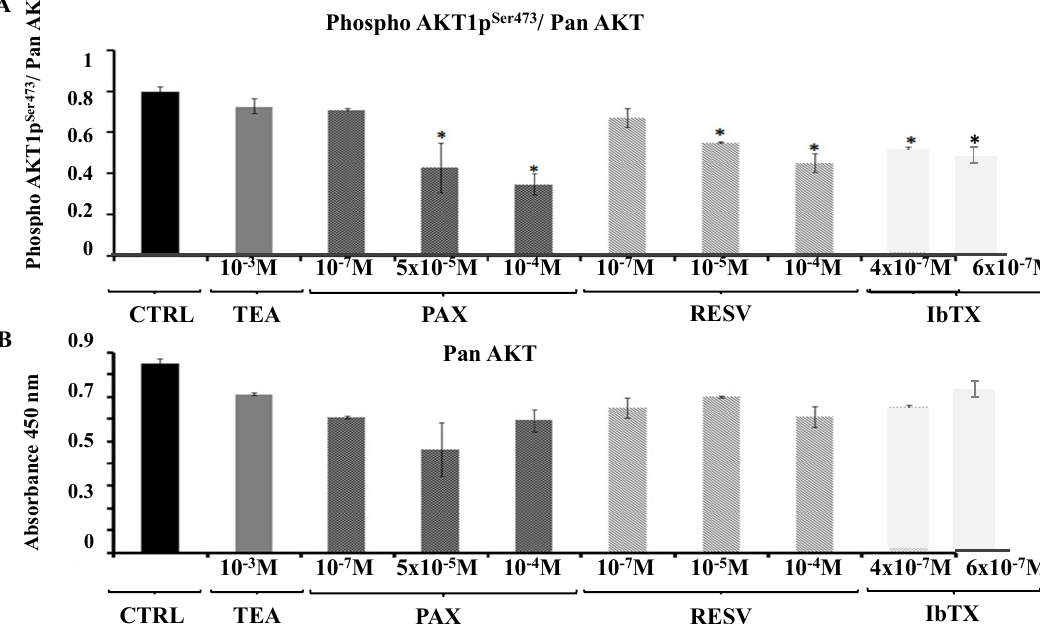
Figure 5. Effects of the Kv/BK channel blockers on the total AKT expression (Pan AKT) and PhosphoAKT (Ser473)/ Pan AKT ratio in SH-SY5Y neuroblastoma cells. The PhosphoAKT (Ser473) and the Pan AKT levels were evaluated in the cell lysates using the ELISA kit for PhosphoAKT (Ser473)-AKT pan (SIGMA Chemical Co., Milan, Italy) in the CTRL condition and after 6 h of incubation with PAX (10 −7 , 5 × 10 −5 and 10 −4 M), IbTX (4 × 10 −7 M), RESV (10 −7 , 10 −5 and 10 −4 M) and TEA (10 −3 M). ( A ) The incubation of cells with PAX, IbTX, and RESV significantly reduced the PhosphoAKT (Ser473) levels. ( B ) No effects were observed on the pan AKT levels reducing the PhosphoAKT (Ser473)/pan AKT ratio. The represented bars correspond to the mean of three different experimental data ± SEM. * Data significantly different with respect to the CTRL condition for p < 0.05 as determined by one-way ANOVA and Bonferroni test.